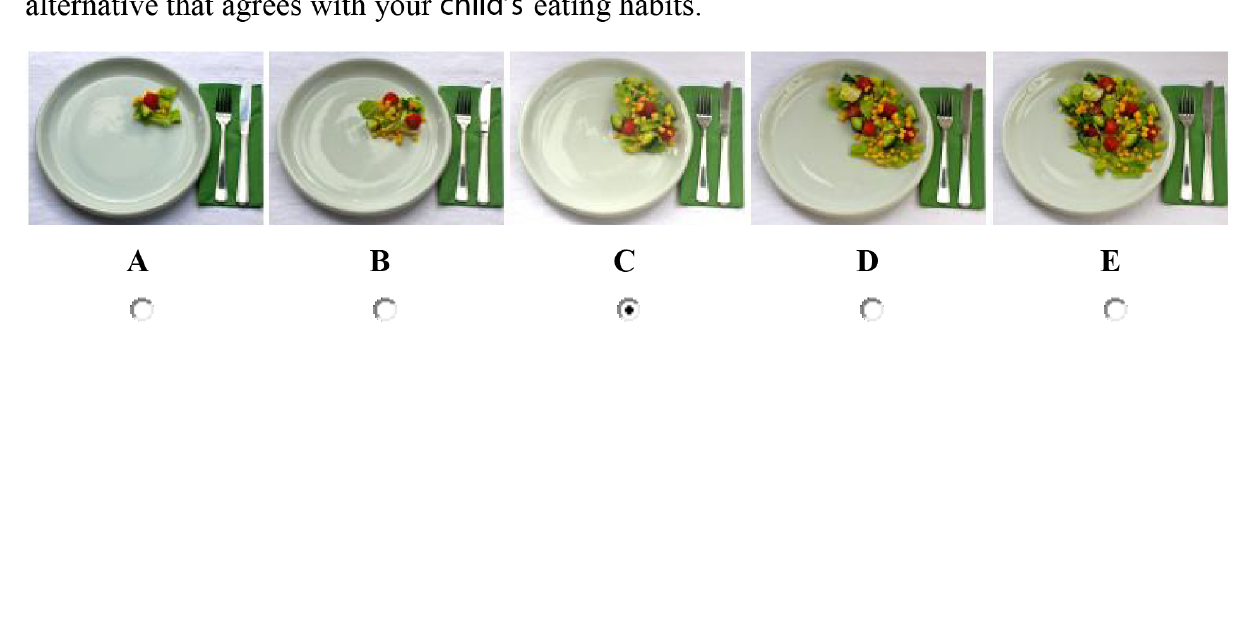
Figure 2. Screenshot of a sample KidMeal-Q question.